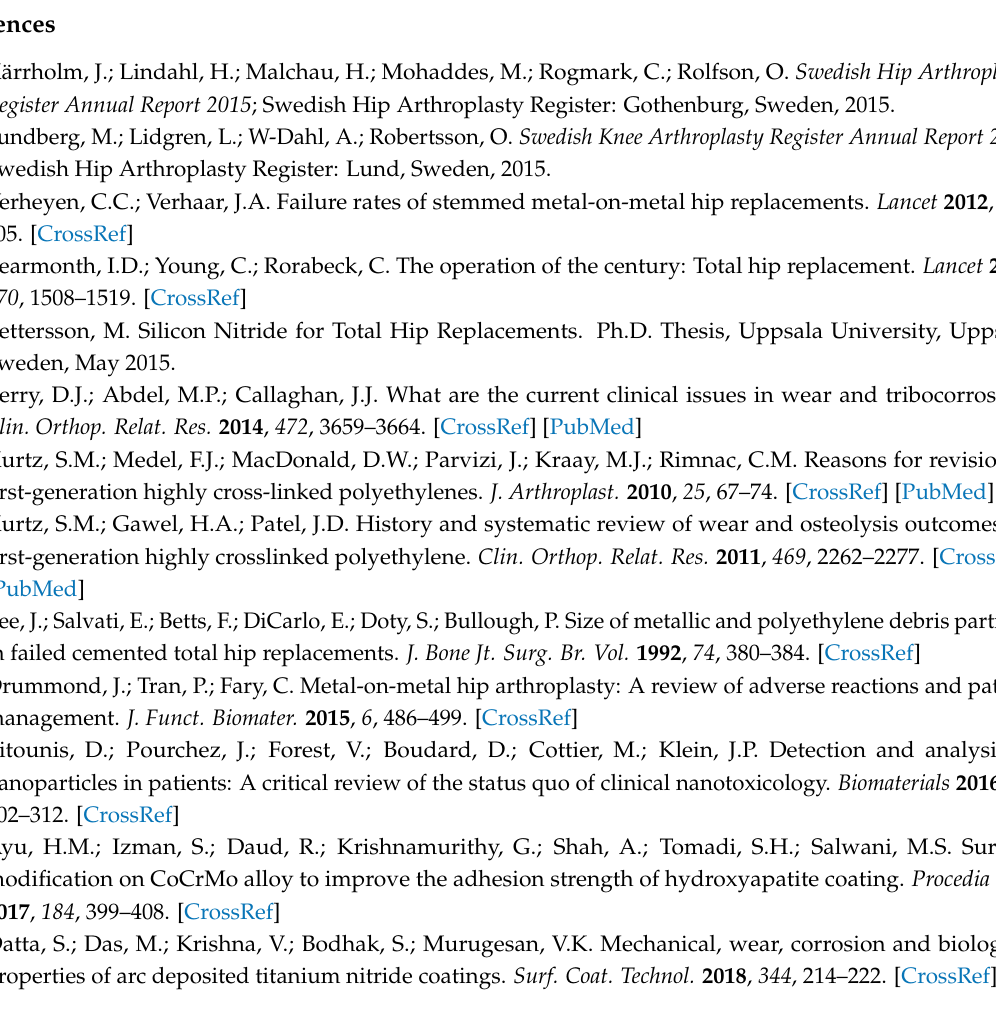
Figure A1. Typical wear tracks from reciprocal wear tests against Si 3 N 4 , as analyzed by Vertical Scanning Interferometry (VSI).